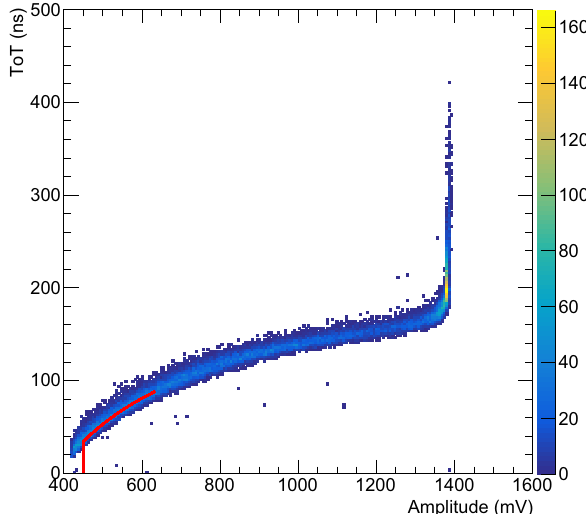
Fig. 13 Correlation between the pulse amplitude and Time-over- Threshold value for a single SiPM. The red curve corresponds to the function described in the